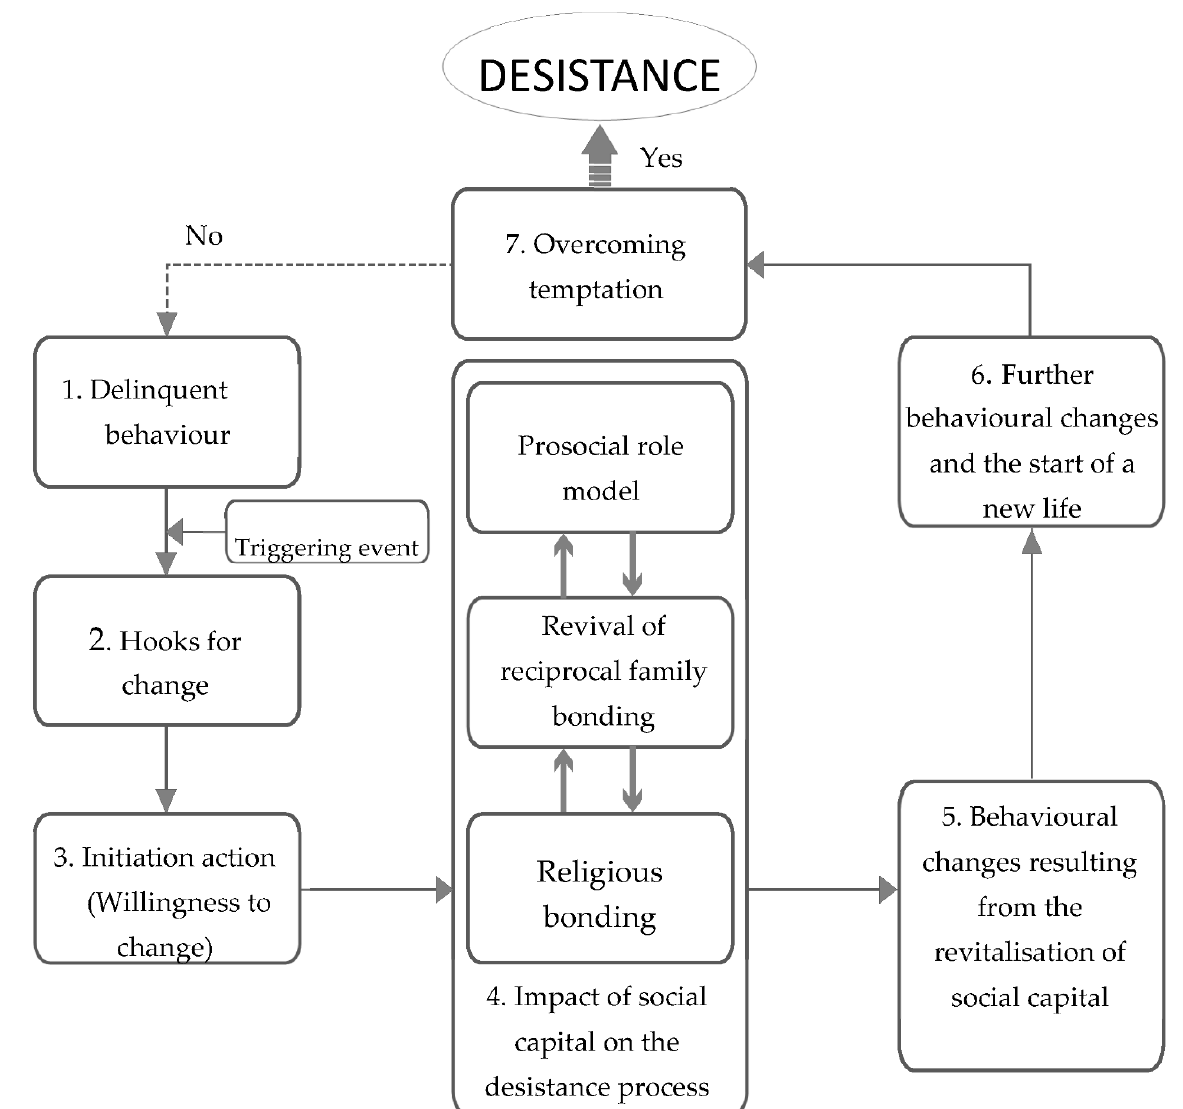
Figure 1. A Model of Stages of Desistance among Hong Kong Youth.